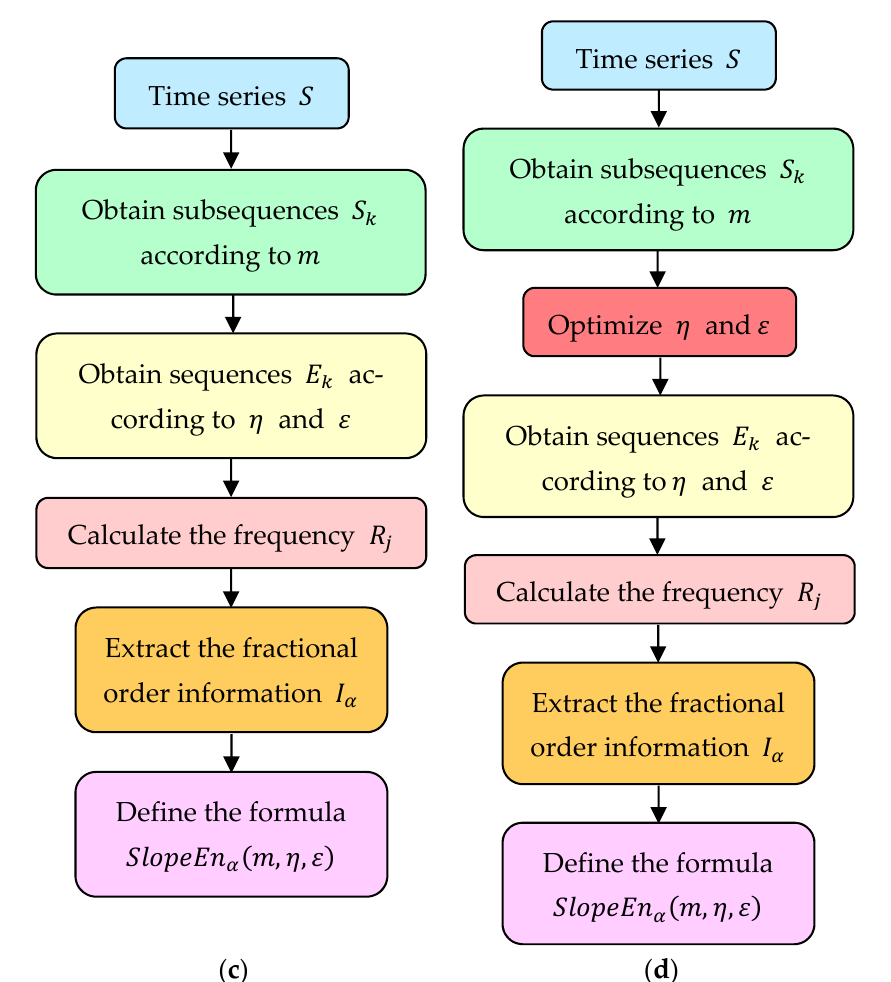
Figure 2. Algorithm flowchart: ( a ) SlEn; ( b ) PSO ‐ SlEn; ( c ) FrSlEn; ( d ) PSO ‐ FrSlEn.